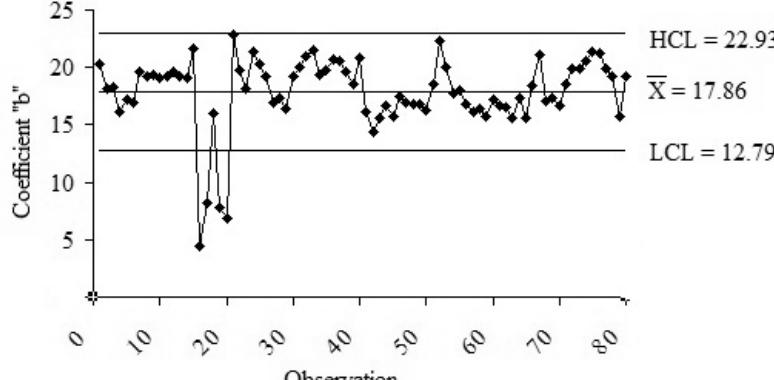
Figure 3. Statistical quality control for the angular coefficient.